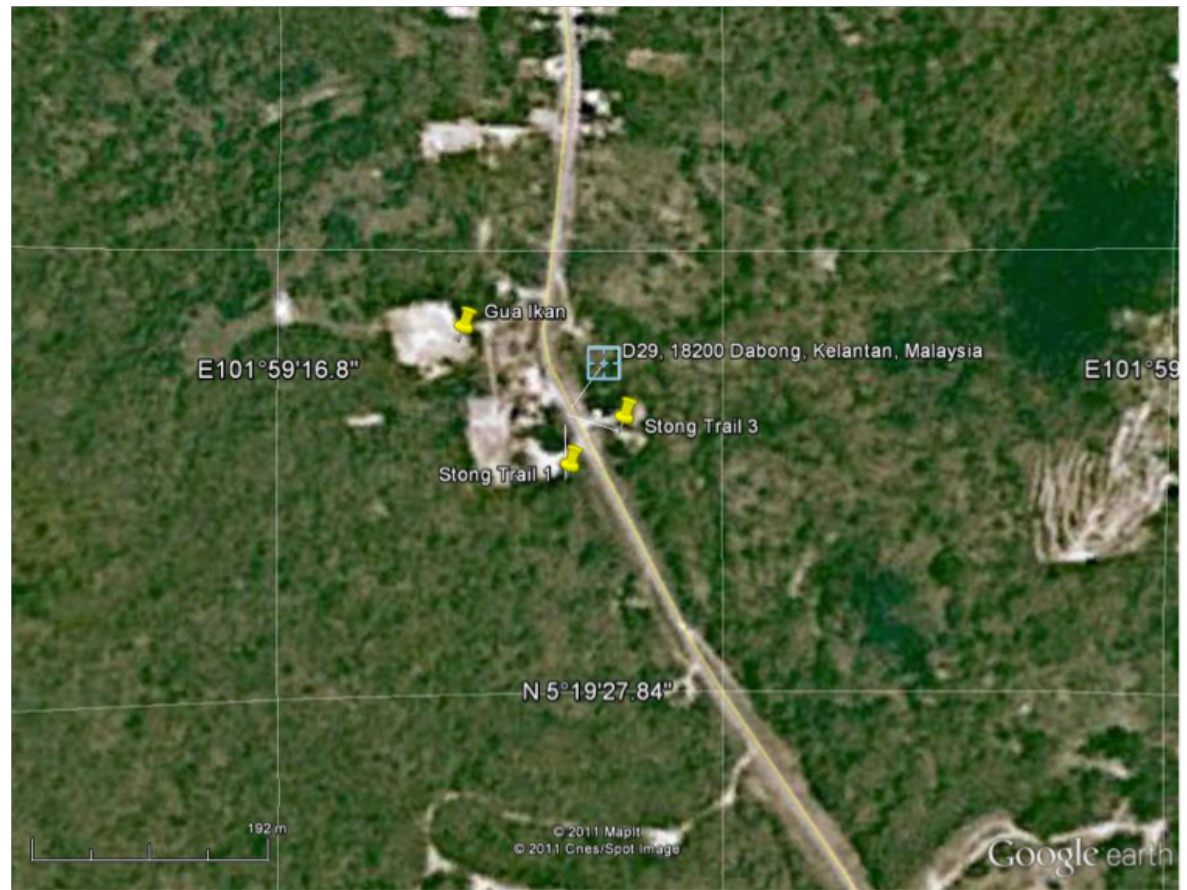
Image 1. Map of the study area (Source: Google Earth,